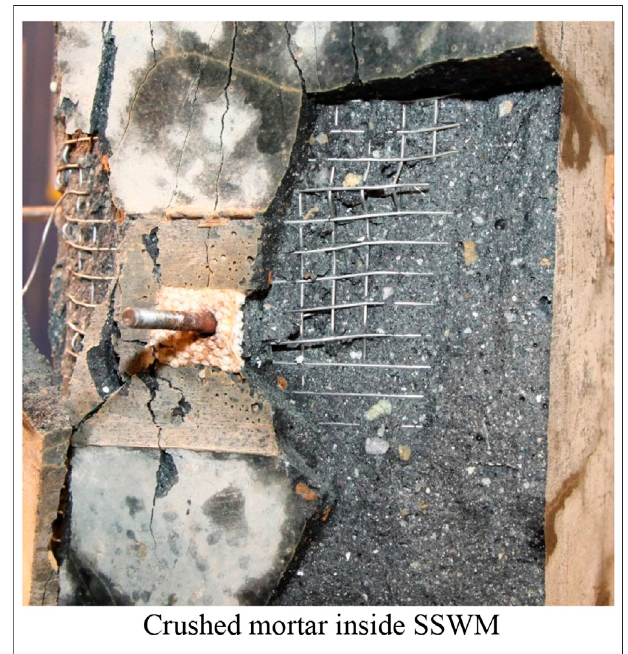
FIGURE 9 | Crushed mortar inside SSWM.